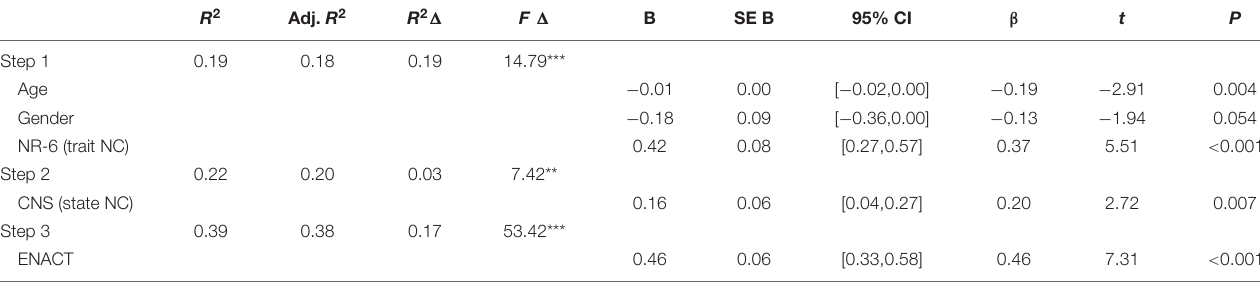
TABLE 4 | Hierarchical regression analysis for predicting behavioral intention (BI; N = 195).